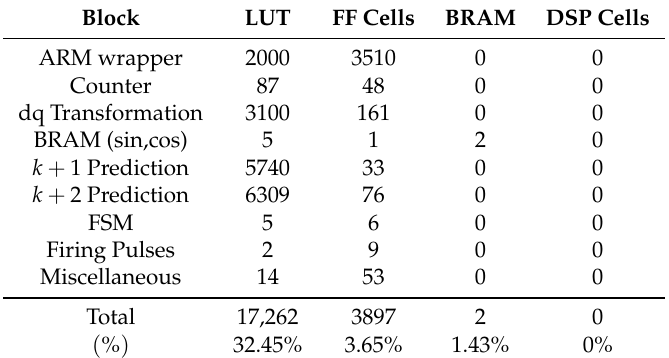
Table 6. Hierarchical utilization for sequential method. No DSP cells.